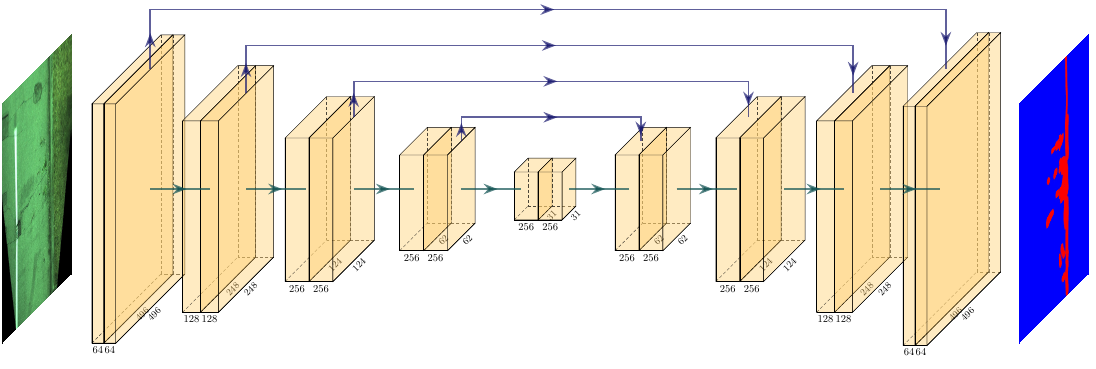
Figure 7. Our Mini U-Net for real-time dirt detection. Notably, the inner layers have just 256 features